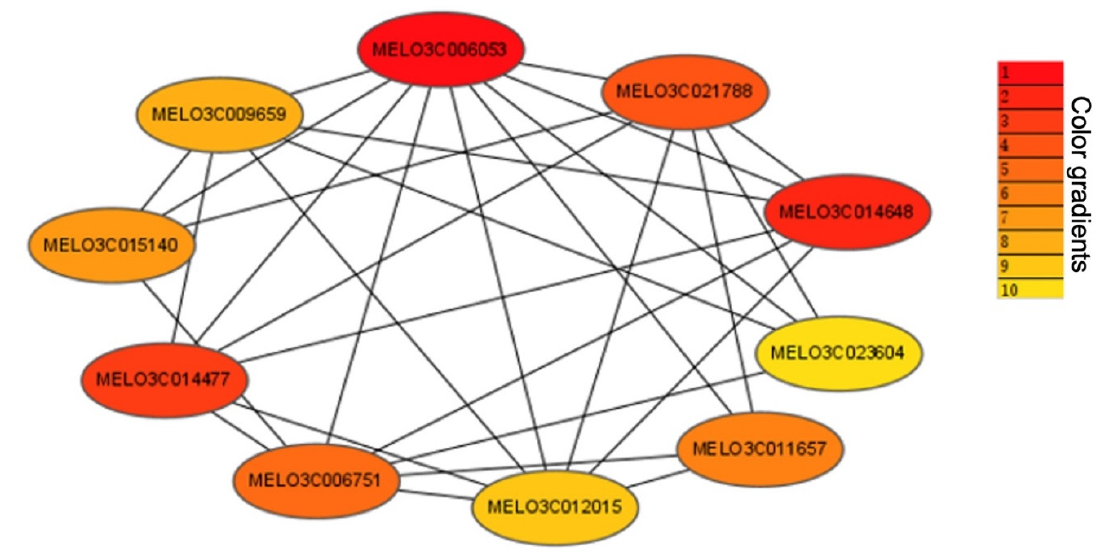
Figure 8. Top 10 hub gene-related networks with weight values in the “black” module. The red color density indicates a higher connectivity, as compared to the light color density.